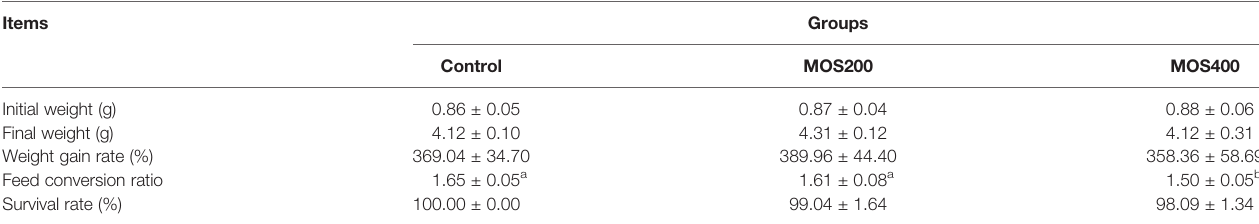
TABLE 2 | Effect of dietary MOS on the growth performance and feed conversion ratio of juvenile M. amblycephala (mean ±